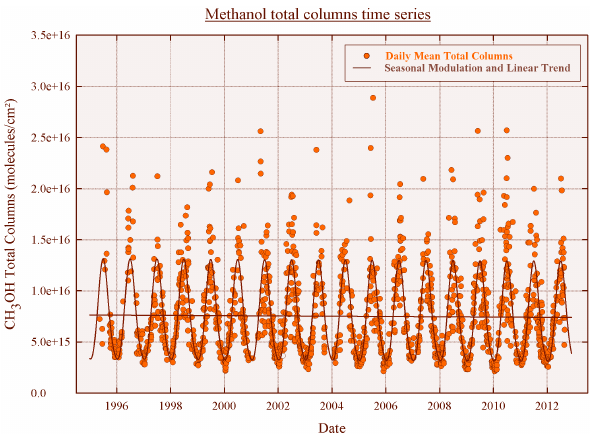
Figure 3. Daily mean total (orange circles) column time series of CH 3 OH above Jungfraujoch. Brown curves show the linear and sea- sonal trend components computed with the bootstrap resampling method (Gardiner et al., 2008).